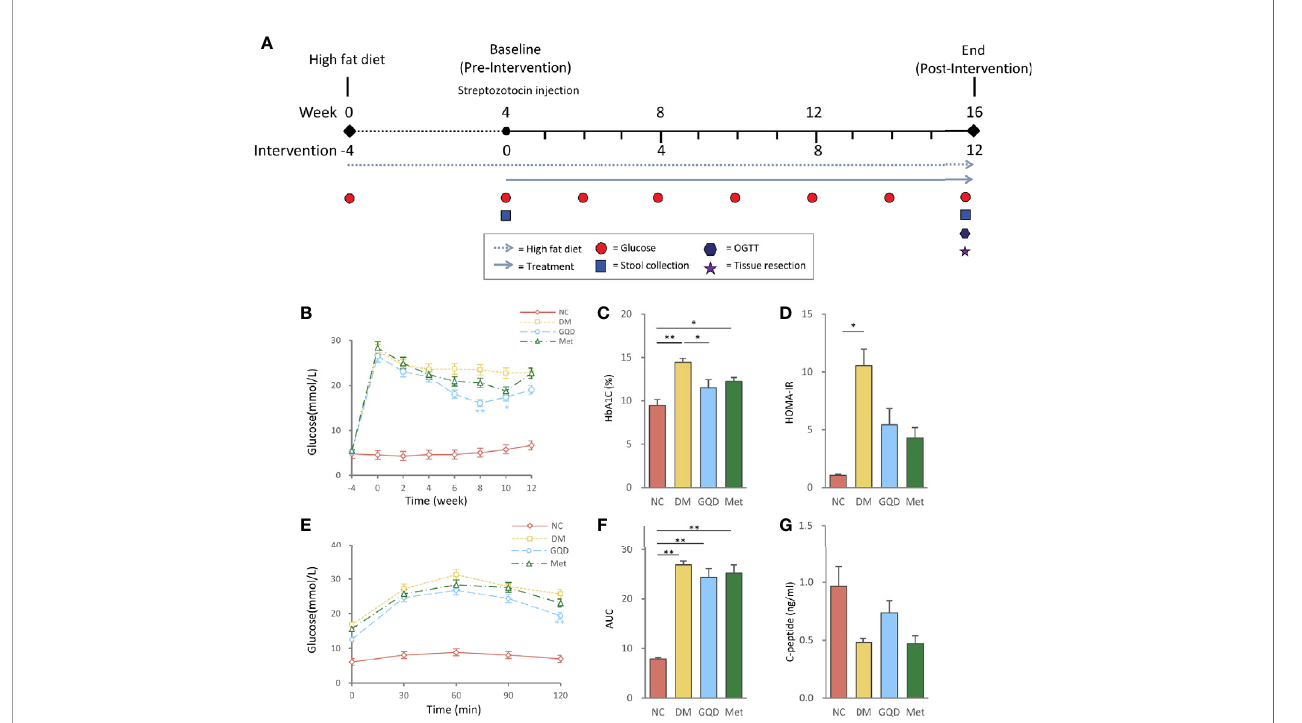
FIGURE 1 | Intervention of GQD decreased blood glucose, and improved oral glucose tolerance and insulin resistance status. (A) Flow diagram of the experimental design. (B) Blood glucose levels over the 12-week experiment. (C) HbA1c levels determined after treatment for 12 weeks. (D) HOMA-IR index was calculated using the following formula: HOMA-IR= FINS × FPG/22.5. (E) Oral glucose tolerance test. (F) AUC calculated from the glucose concentrations versus time for the period of 0-120 min after glucose load by the trapezoidal rule. (G) Serum C-peptide levels determined after treatment for 12 weeks. Values are expressed as means ± SE. Differences were assessed by ANOVA: **p < 0.01, *p < 0.05. HbA1c, glycosylated hemoglobin; HOMA-IR, homeostasis model assessment for insulin resistance; FINS, fasting insulin; FPG, fasting plasma glucose; NC, normal control; DM, diabetes mellitus; GQD, Gegen Qinlian Decoction; Met,